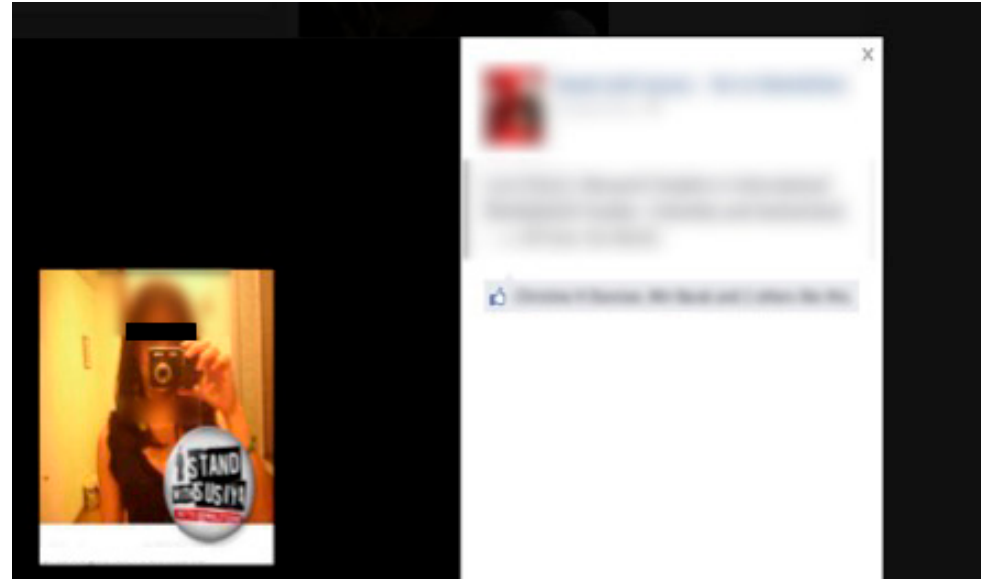
Figure 4. Example of the Susiya pic-badge used for a social media profile. Screen grab from the Stand with Susiya—No to Demolition Facebook gallery (Accessed on 12 July 2012).